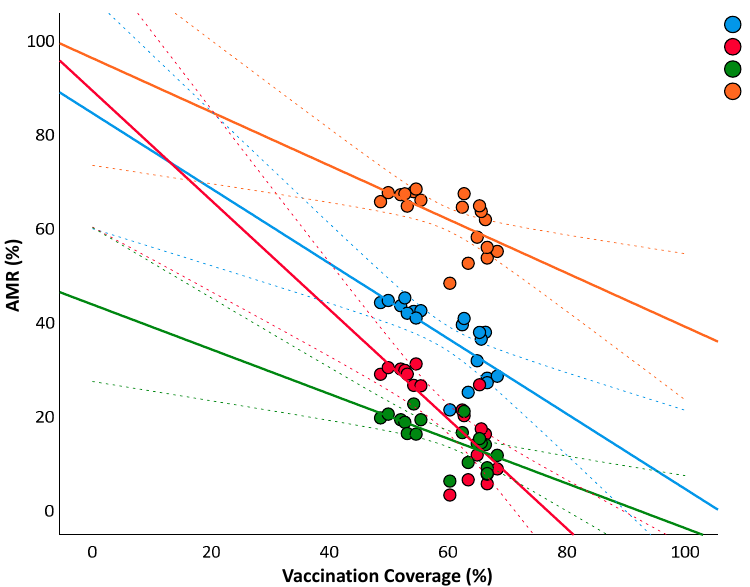
Figure 3. The relationship between influenza vaccination coverage in population over 64 years and antimicrobial resistance of Escherichia coli . The plot shows linear regression lines and their 95%CI (dotted lines).